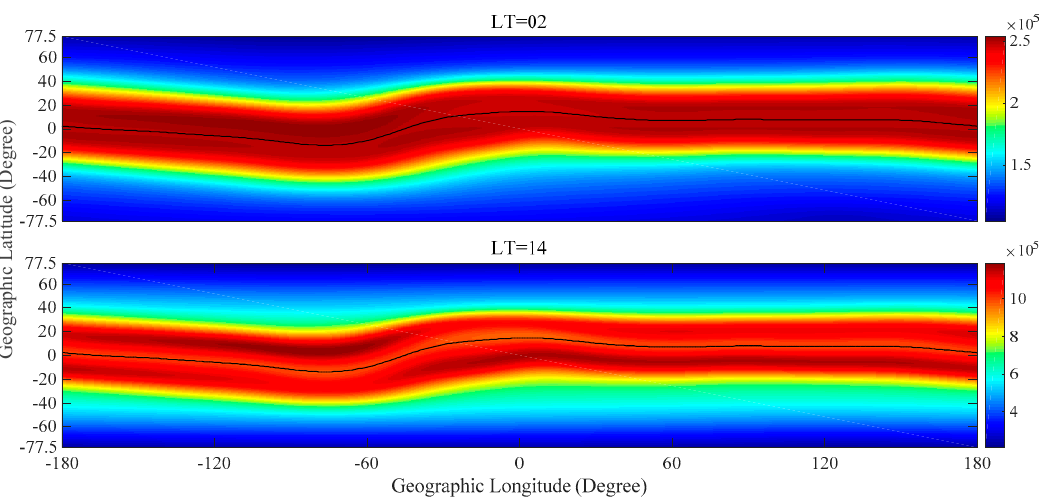
Figure 9. Global distribution of NPDM NmF2 (cm − 3 ) at the September equinox under low (F10.7 = 80 sfu) solar activity.